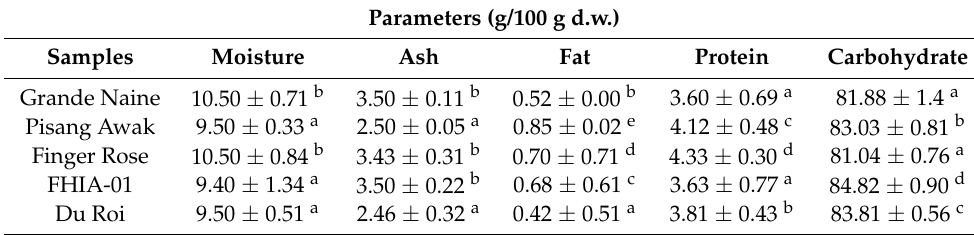
Table 1. Proximate analyses of green banana cultivars grown in South Africa. Parameters (g/100 g